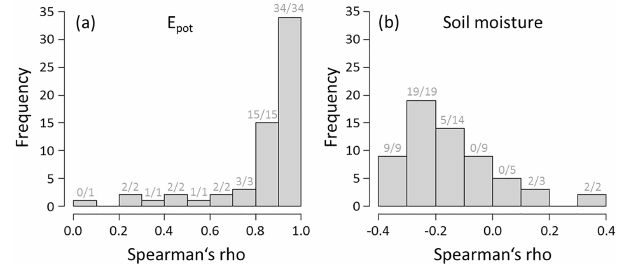
Figure 3. Histograms of temporal correlations between (a) E pot and (b) soil moisture at each site with sap velocity for the 61 trees in the dataset. The small numbers in grey on top of the bars indicate how many of the correlations in the specific group are